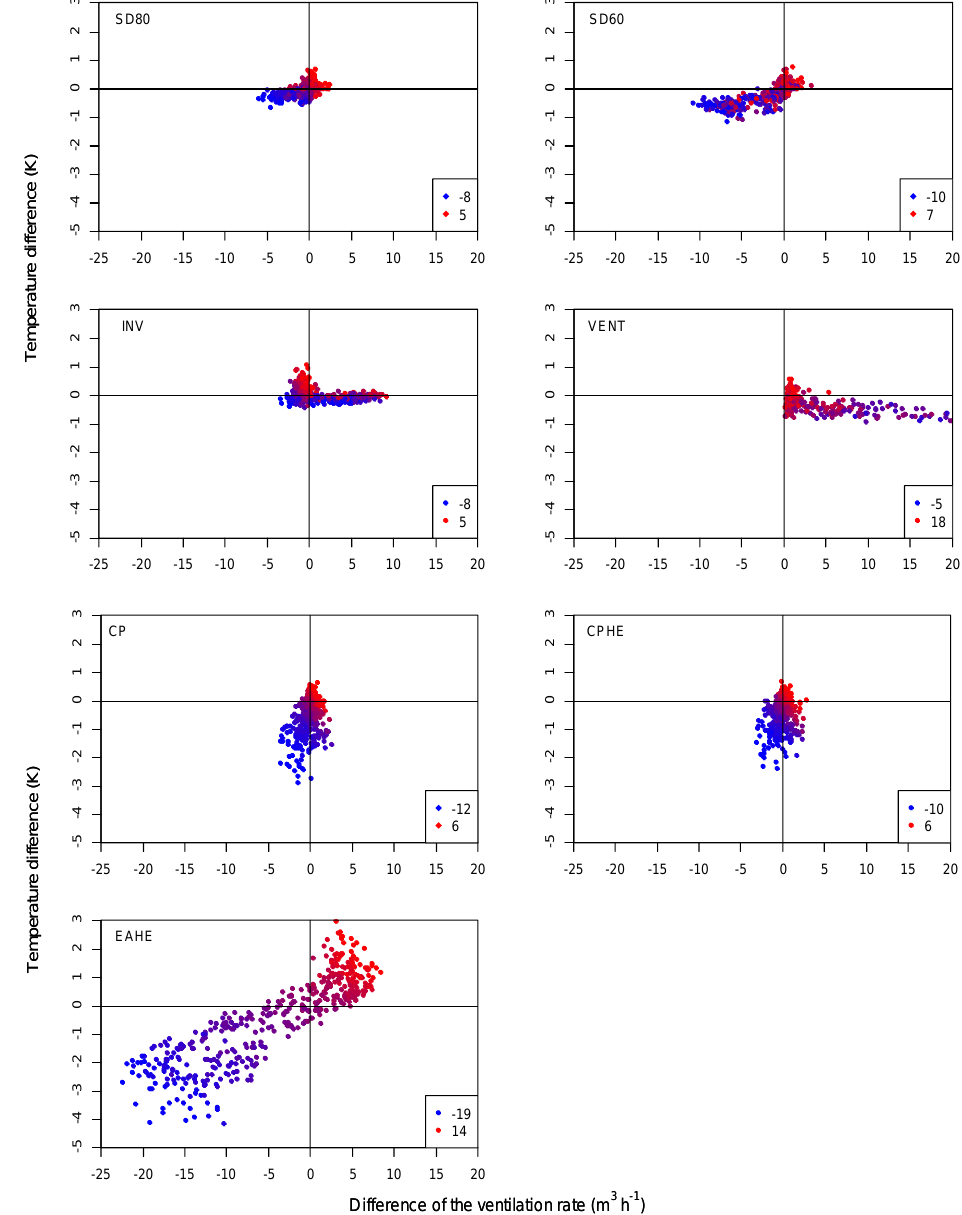
Difference of the ventilation rate (m 3 h -1 ) Figure 4. Scatterplot of monthly mean values (period 1981 – 2017) of the relative modification of the NH 3 emission MOD (blue: decrease; red: increase) depending on the indoor temperature difference (K) and the difference of the ventilation rate per animal place (m³ h − 1 ) between a specific AM and the reference building REF. The numbers in each plot give the maximum decrease (in blue) and increase (in red) of MOD. Adaptation measures: stocking density SD80%; stocking density SD60%; inversion of the resting and activity periods INV; doubling the ventilation rate VENT; cooling pads CP; cooling pads and heat exchanger CPHE; and earth-air heat exchanger EAHE.